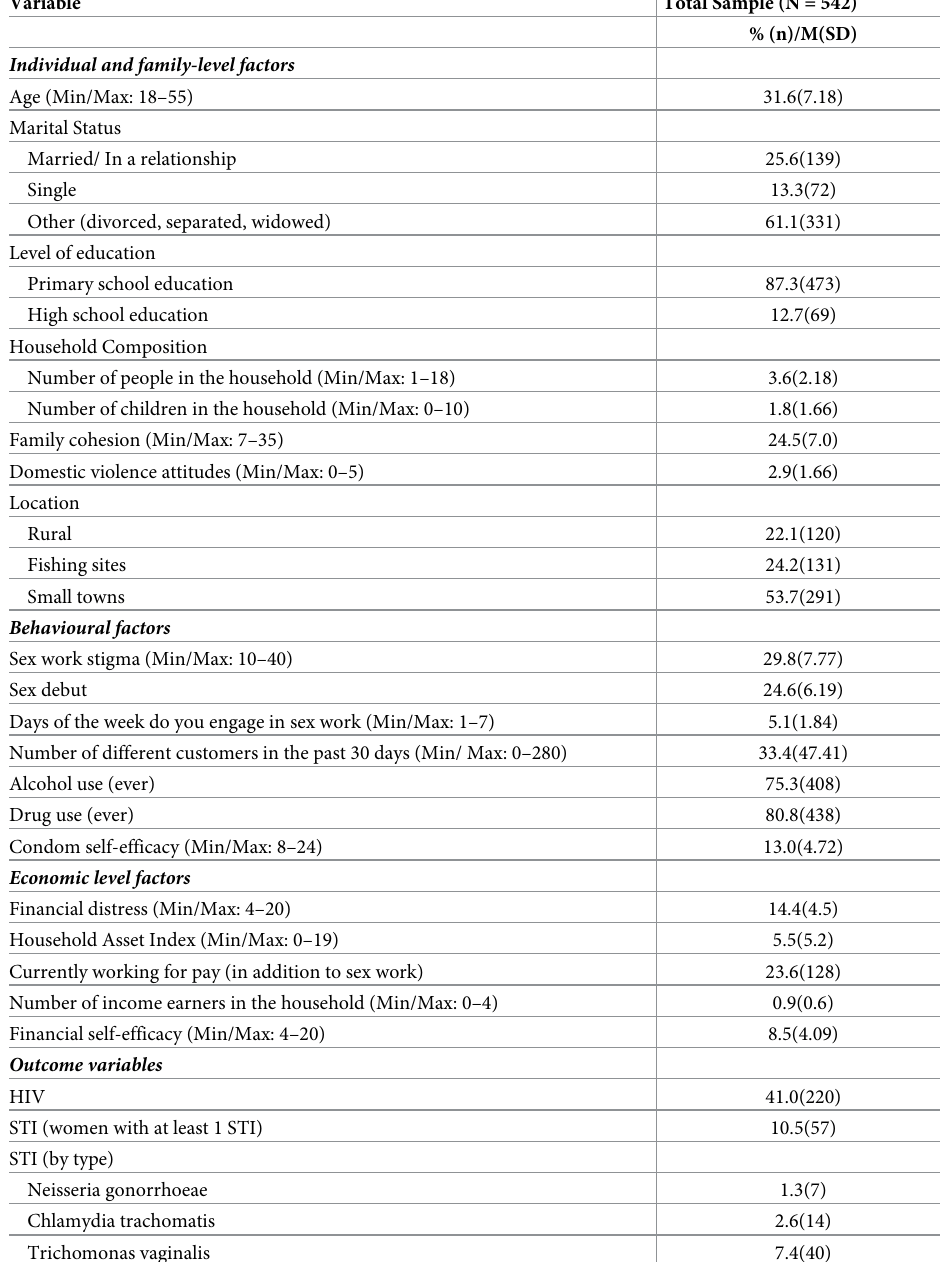
Table 1. Description and characteristics of the population